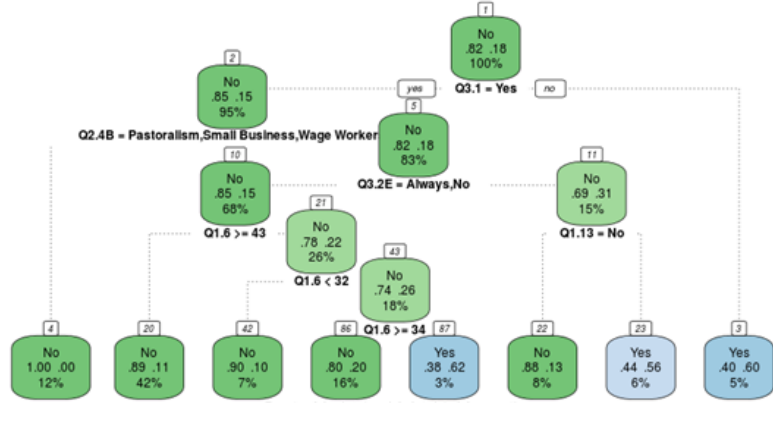
Figure 2: CART with optimum